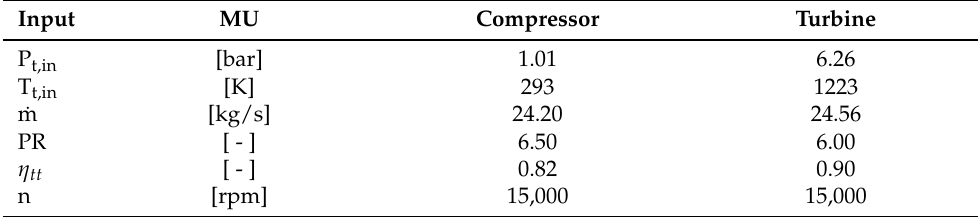
Table 2. Design parameters from gas cycle calculation